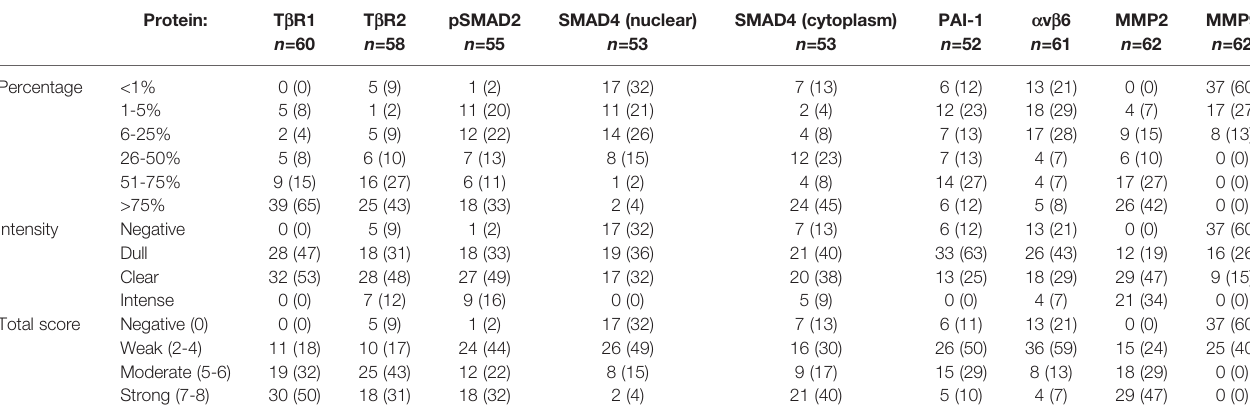
TABLE 2 | Protein expression